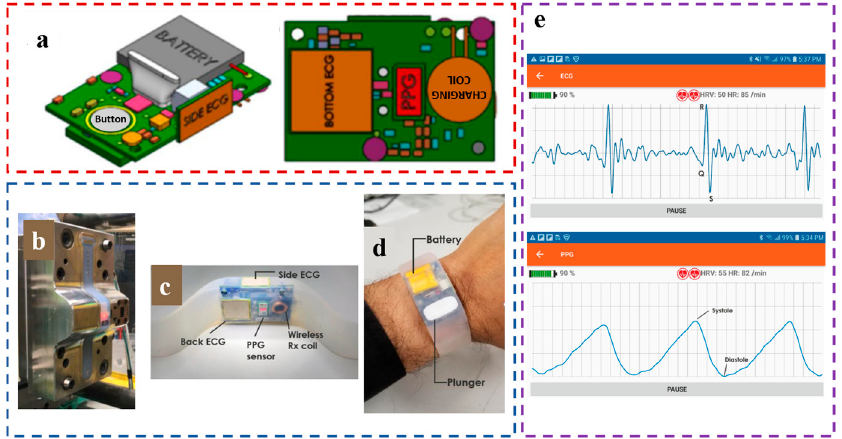
Figure 7. ( a ) Top and bottom views of the mechanical CAD model showing component placement following complete assembly; ( b ) An over-molded PCBA in clear silicone; ( c ) Some visible compo- nents labeled; ( d ) Wearable wristband; ( e ) App UI showing the live ECG signal and PPG signal. Reproduced with permission from [65].